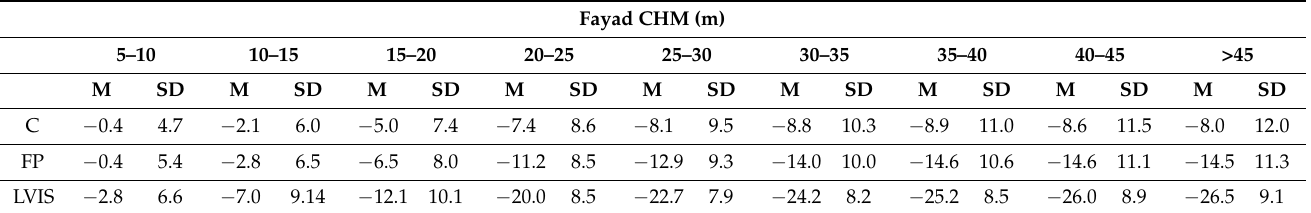
Table A1. Mean (M) and standard deviation (SD) in meters of the elevation difference between ELM and SRTM. (C) and (FP) correspond to the ELM values from GEDI’s coverage and full-power lasers, respectively. (LVIS) corresponds to the ELM values from LVIS.